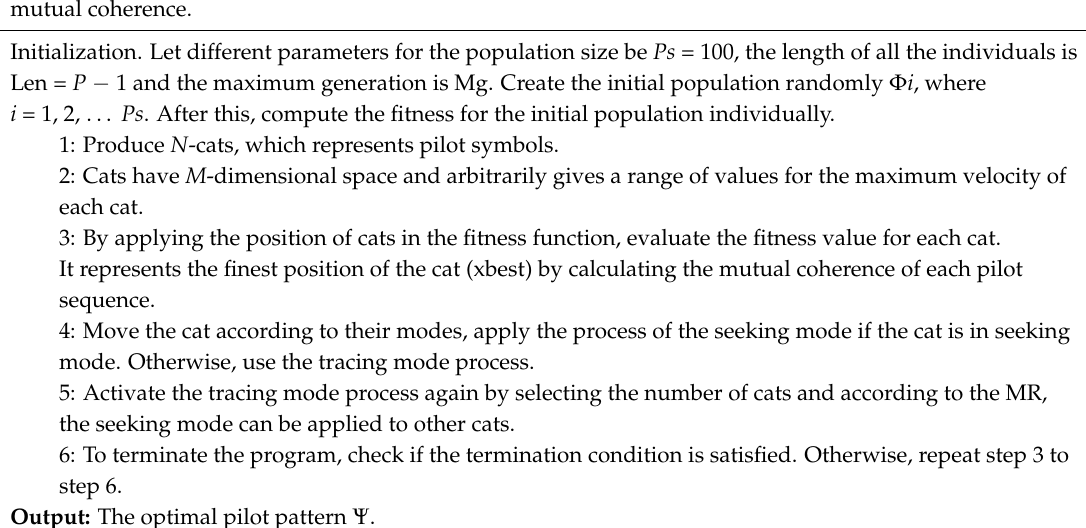
Algorithm 1: Pseudo code for the CSO based optimal pilot pattern for reducing the largest element in mutual